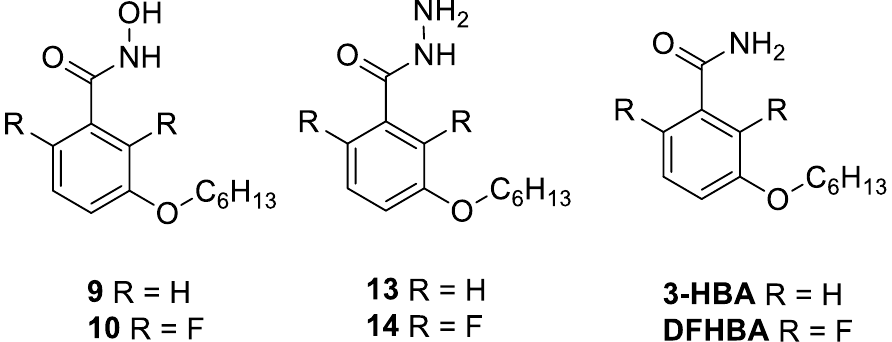
Figure 5. Structure of the known FtsZ inhibitors 3-HBA and DFHBA and of analogues 9 , 10 , 13 , 14 .